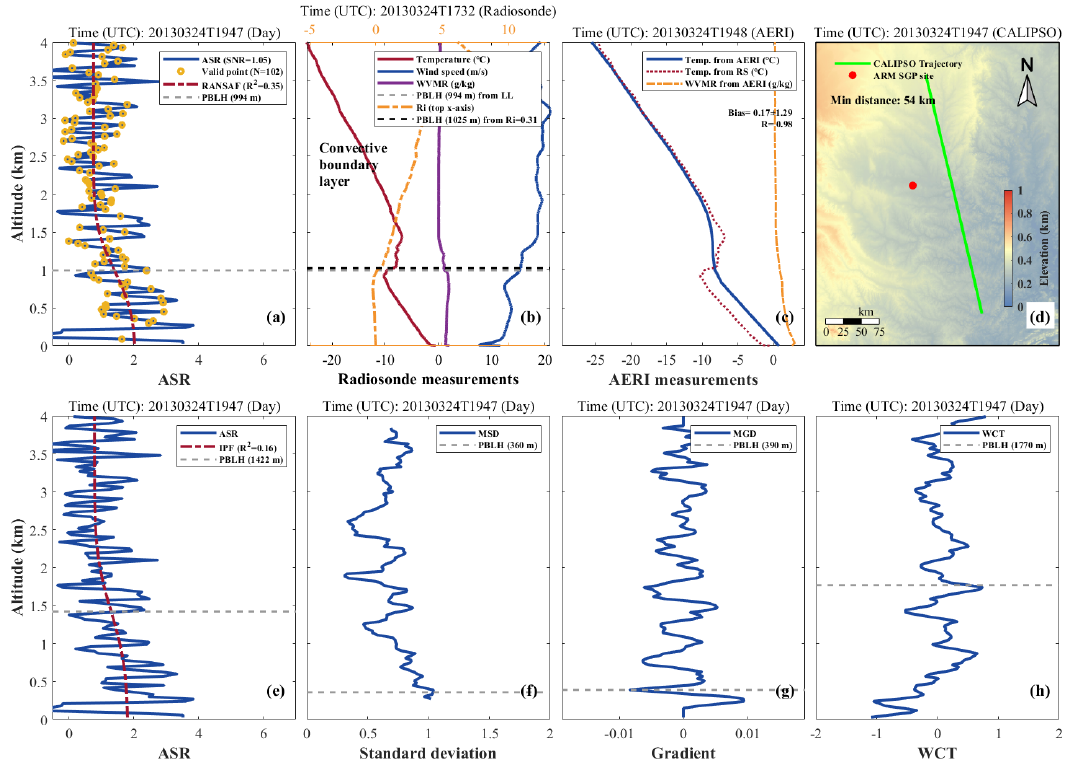
Figure 6. ASR was measured by CALIOP at 19:47:51 UTC (day) on 24 March 2013; PBLHs were determined with the ( a ) RANSAF, ( b ) radiosonde (RS), ( e ) IPF, ( f ) MSD, ( g ) MGD, and ( h ) WCT methods; ( c ) vertical profile of temperature and water vapor mixing ratio (WVMR) retrieved from AERI with the red dotted line referring to temperature measured by RS in ( b ), Bias (R) is the mean difference (correlation coefficient) between temperature profiles from AERI and RS; ( d ) ARM SGP site of radiosonde observations and CALIPSO trajectory. The minimum distance between the CALIOP and radiosonde (AERI) measurements are shown in the top of subfigure ( d ).